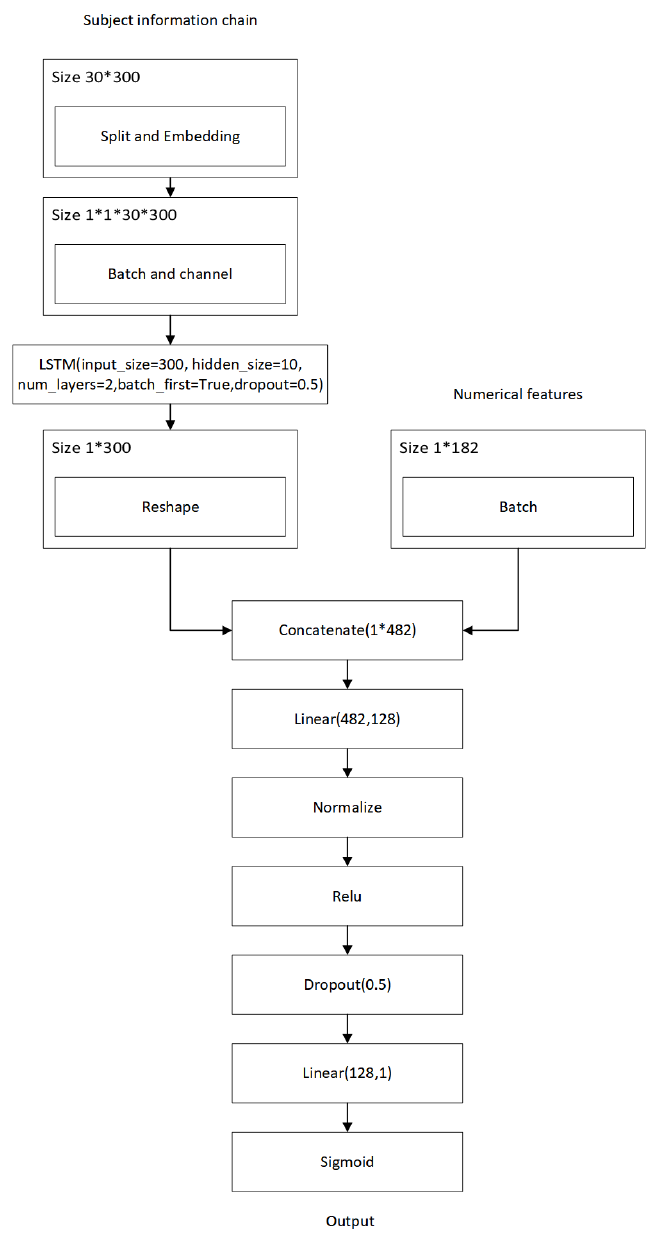
Figure A2. Details of the LSTM-based